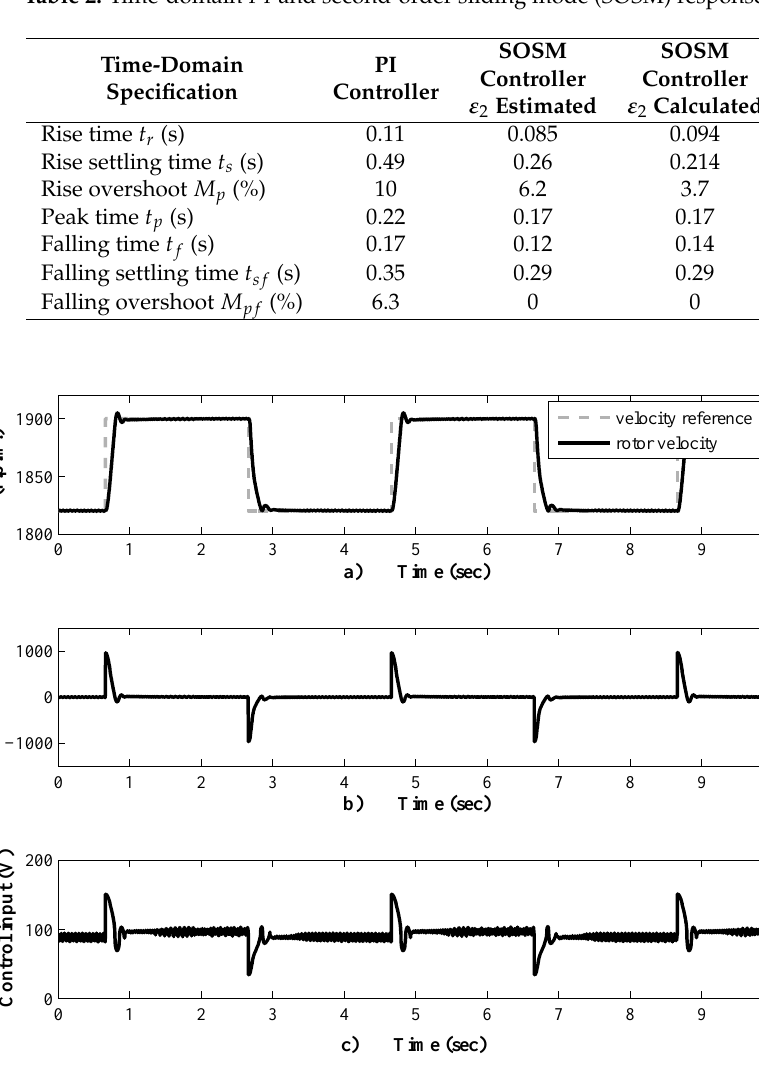
Table 2. Time-domain PI and second-order sliding mode (SOSM) responses.